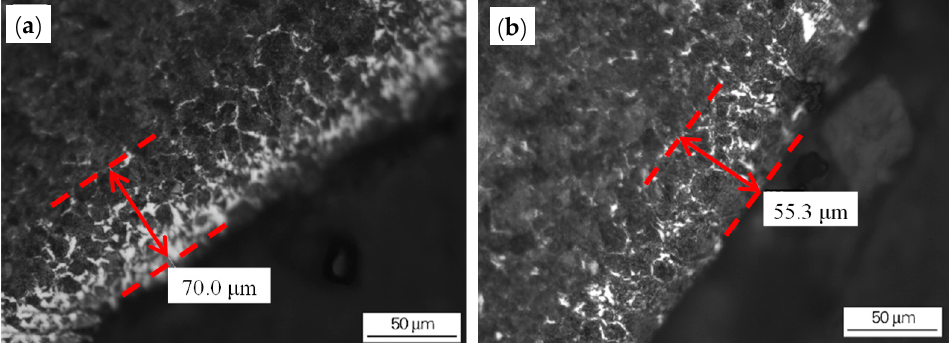
Figure 3. Effect of the grinding of the blank surface on the decarburization layer of the rolled wire rod: ( a ) blank (unpolished) surface and ( b ) the decarburized layer on the polished surface of the rolled wire rod. Reprinted with permission from ref. [10]. Figure 4. Relationship between the thickness of the original decarburized layer of the billet and the thickness of the wire rod. Reprinted with permission from ref. [10].